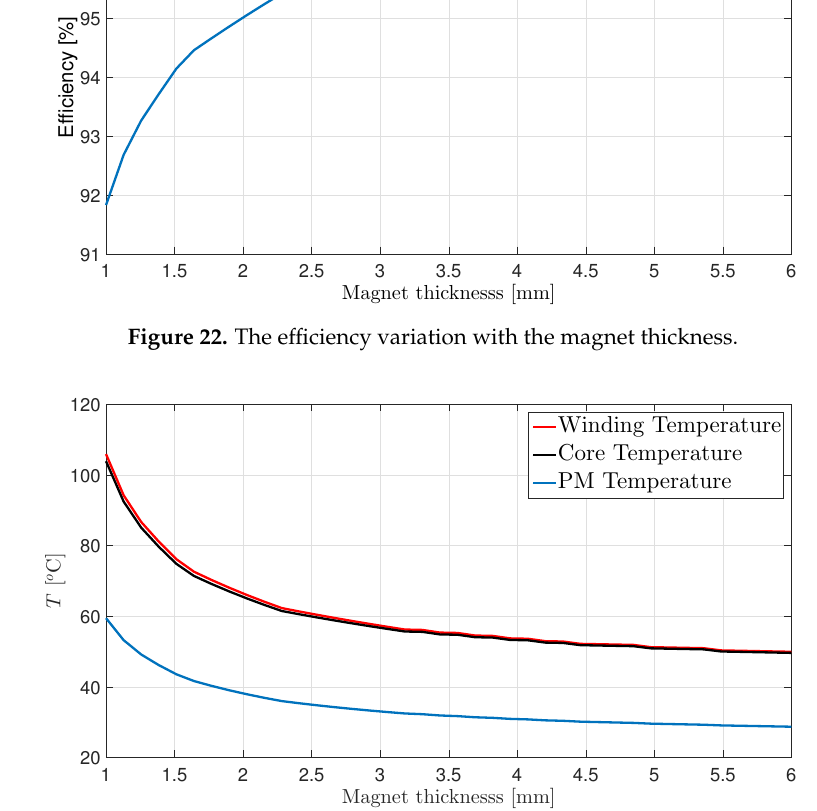
Figure 23. The temperature variation with the magnet